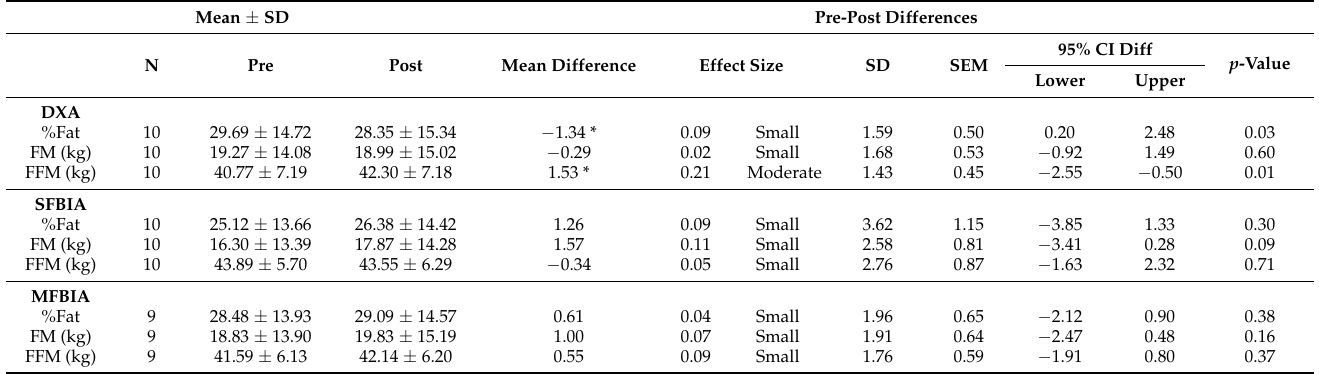
Table 2. Pre- and post-intervention differences in body composition metrics within each assess- ment